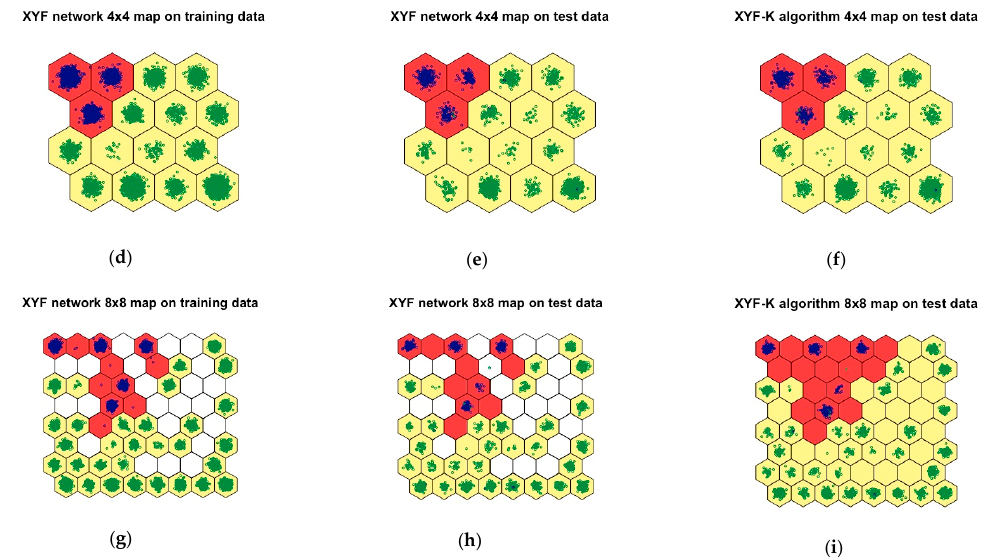
Figure 7. XYF network and XYF-K algorithm on the different neurons map sizes for the mixed dataset. ( a ) XYF network 2 × 2 map on training data; ( b ) XYF network 2 × 2 map on test data; ( c ) XYF-K algorithm 2 × 2 map on test data; ( d ) XYF network 4 × 4 map on training data; ( e ) XYF network 4 × 4 map on test data; ( f ) XYF-K algorithm 4 × 4 map on test data; ( g ) XYF network 8 × 8 map on training data; ( h ) XYF network 8 × 8 map on test data; ( i ) XYF-K algorithm 8 × 8 map on test data.